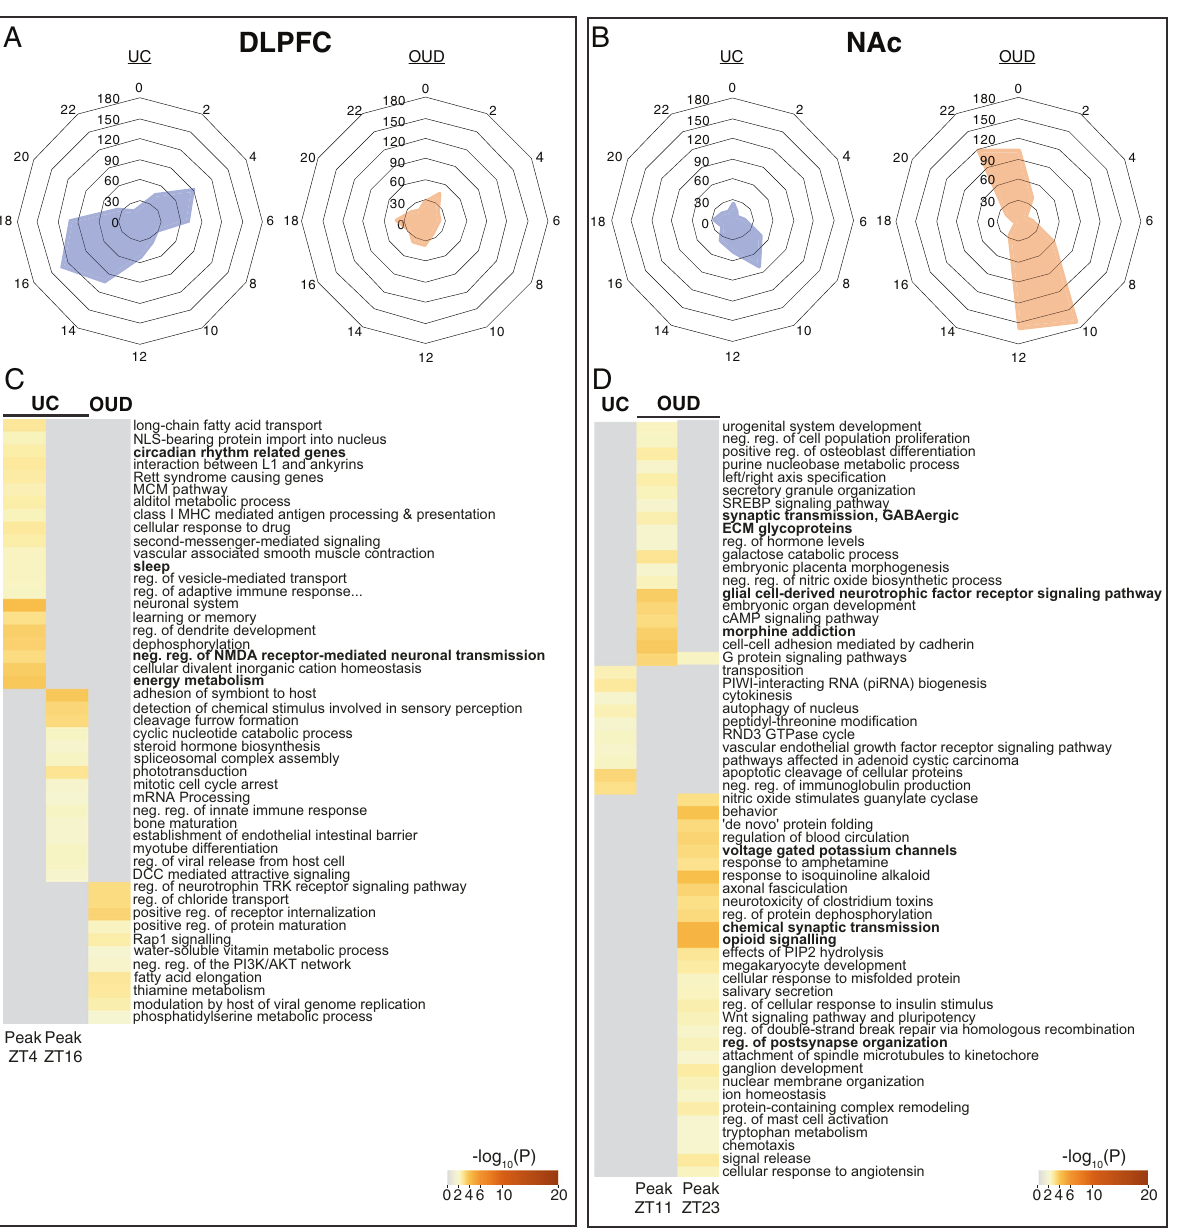
Fig. 2 Distinct peak times for rhythmic transcripts in subjects with opioid use disorder (OUD) compared to unaffected comparison (UC) subjects. A In the dorsolateral prefrontal cortex of UC subjects, transcripts generally peaked at either ZT4 or ZT16, ~12 h apart. Rhythmic transcripts in the DLPFC in subjects with OUD did not peak at consistent times. B In the nucleus accumbens (NAc), rhythmic transcripts in UC subjects generally peaked at ZT10. Rhythmic transcripts in the NAc of subjects with OUD peaked at either ZT11 or ZT23, ~12 h apart. C Transcripts peaking at ZT4 in the DLPFC of UC subjects were enriched for pathways related to rhythms (e.g., circadian rhythm-related genes, sleep) and neurotransmission (e.g., negative regulation of NMDA receptor-mediated neuronal transmission), while transcripts peaking at ZT12 were enriched for immune-related pathways (e.g., adhesion of symbiont to host, negative regulation of innate immune response). Rhythmic transcripts in the DLPFC of OUD subjects were enriched for regulation of neurotrophin TRK receptor signaling pathway and positive regulation of receptor internalization. D Rhythmic transcripts in the NAc of OUD subjects were enriched for apoptotic cleavage of cellular proteins. In the NAc of OUD subjects, rhythmic transcripts peaking at ZT11 were enriched for morphine addiction, glial cell-derived neurotrophic factor receptor signaling, ECM glycoproteins, and synaptic transmission, GABAergic, while transcripts peaking at ZT23 were enriched for opioid signaling, voltage-gated potassium channels, and synapse-related pathways (e.g., regulation of postsynapse organization, chemical synaptic DLPFC and NAc of OUD subjects and sleep-related phenotypes. subjects were enriched for pathways related to the regulation of Additionally, we identi fi ed transcripts that were signi fi cantly less dopamine neurotransmission. Using integrative analyses combin- rhythmic in OUD subjects, also with signi fi cant associations to ing circadian patterns of transcriptional regulation and human sleep GWAS. An important consideration is that our fi ndings may GWAS, our fi ndings revealed novel gene-trait relationships be driven, in part, by acute opioid administration, as most subjects between transcripts that were signi fi cantly more rhythmic in